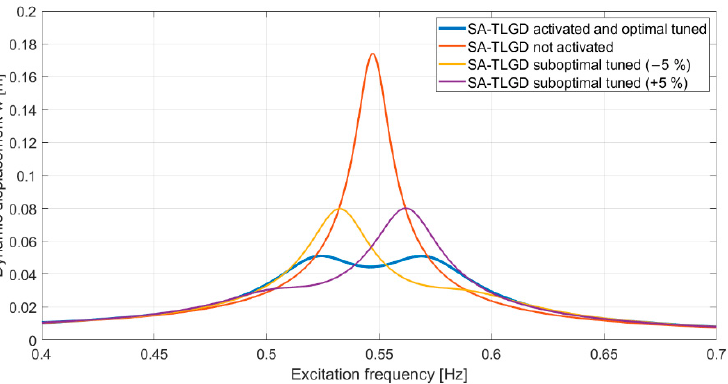
Figure 7. Frequency response functions (FRF) of the SDOF-wind turbine with sub-optimal tuned SA-TLGD (frequency shift of the wind turbine fundamental mode f S = 0.55 Hz to 𝑓 (cid:3020)(cid:2878)(cid:2873)% = 0.58 Hz and 𝑓 (cid:3020)(cid:2879)(cid:2873)% = 0.52 Hz assumed).